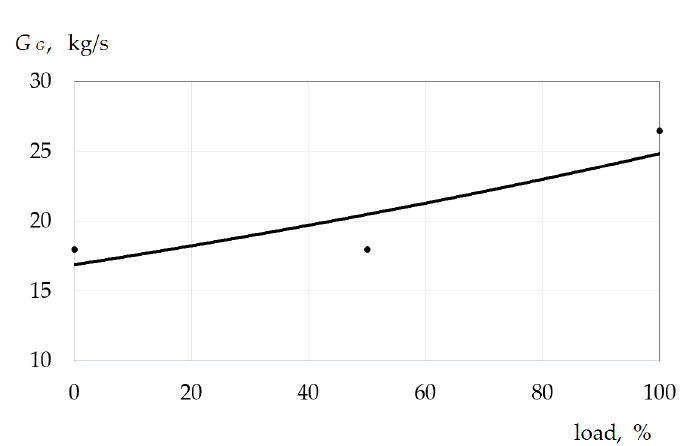
Figure 17. Dependence of gas flow rate in the combustion zone on the load value.